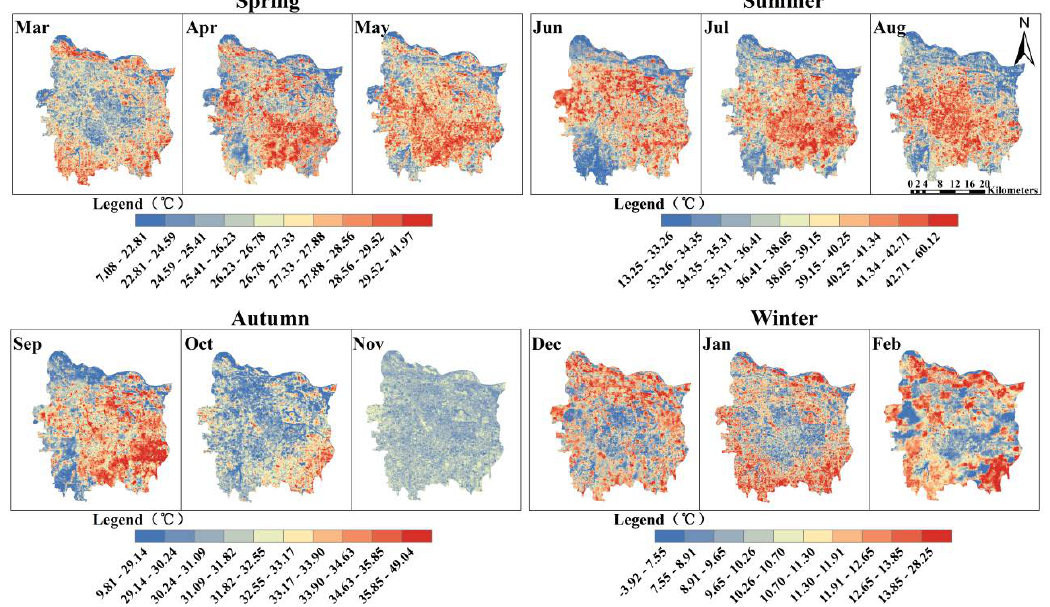
Figure 14. The distribution of monthly “Landsat-like” LSTs in 2013.